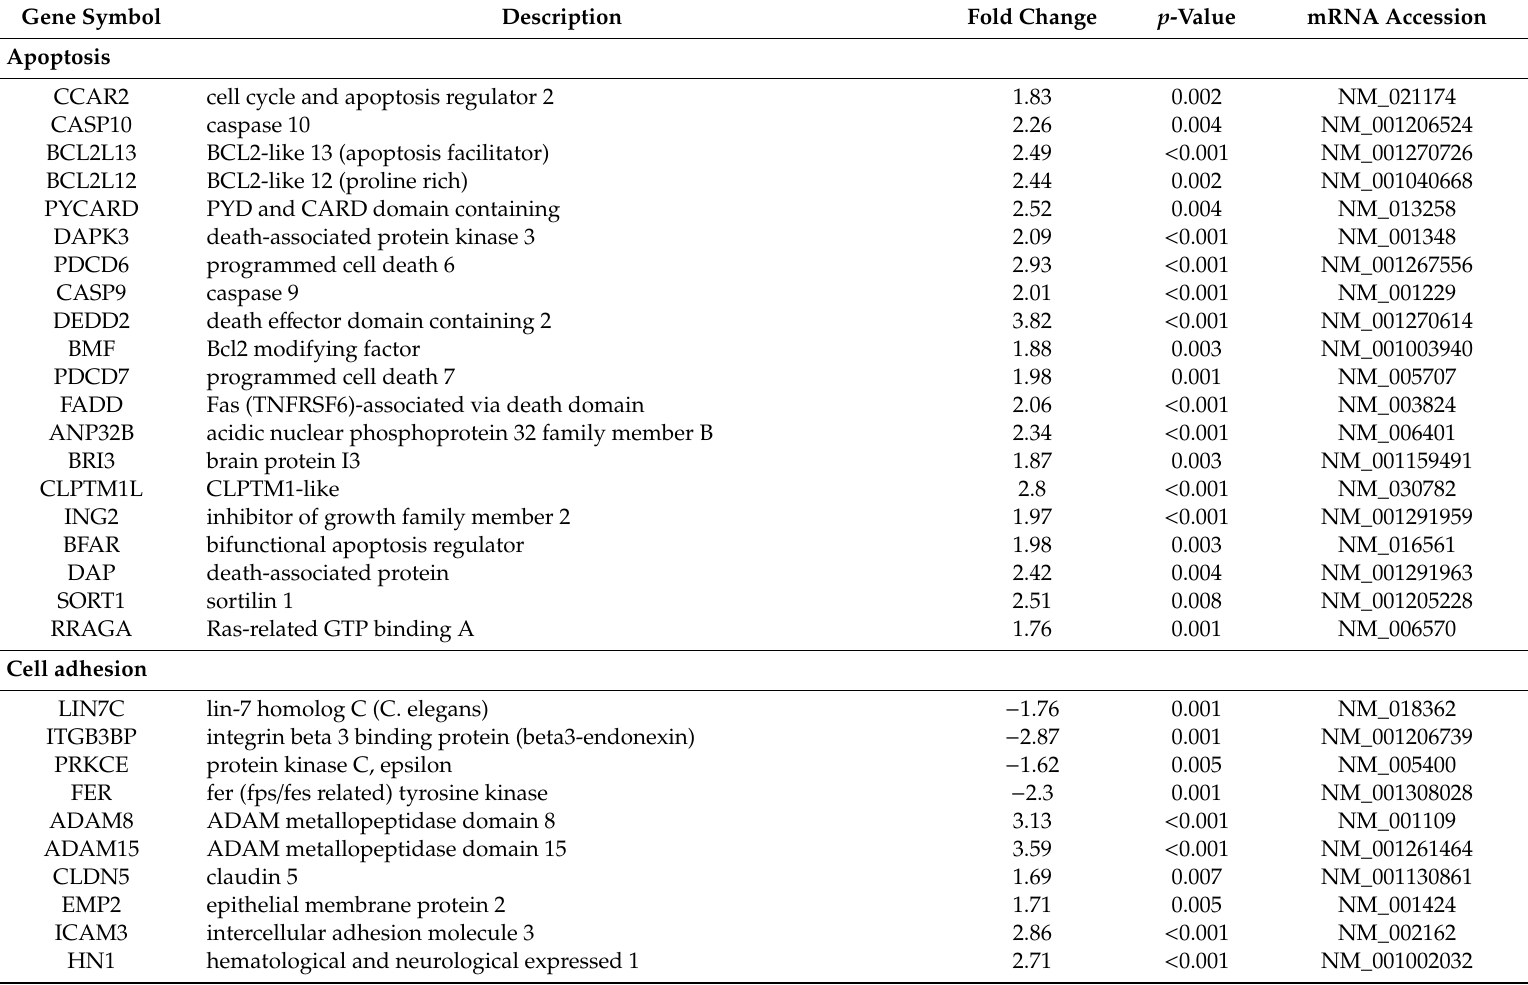
Table 1. Selection of significant di ff erentially expressed genes in pSjS patients versus healthy subjects, grouped according to the biological processes to which they are